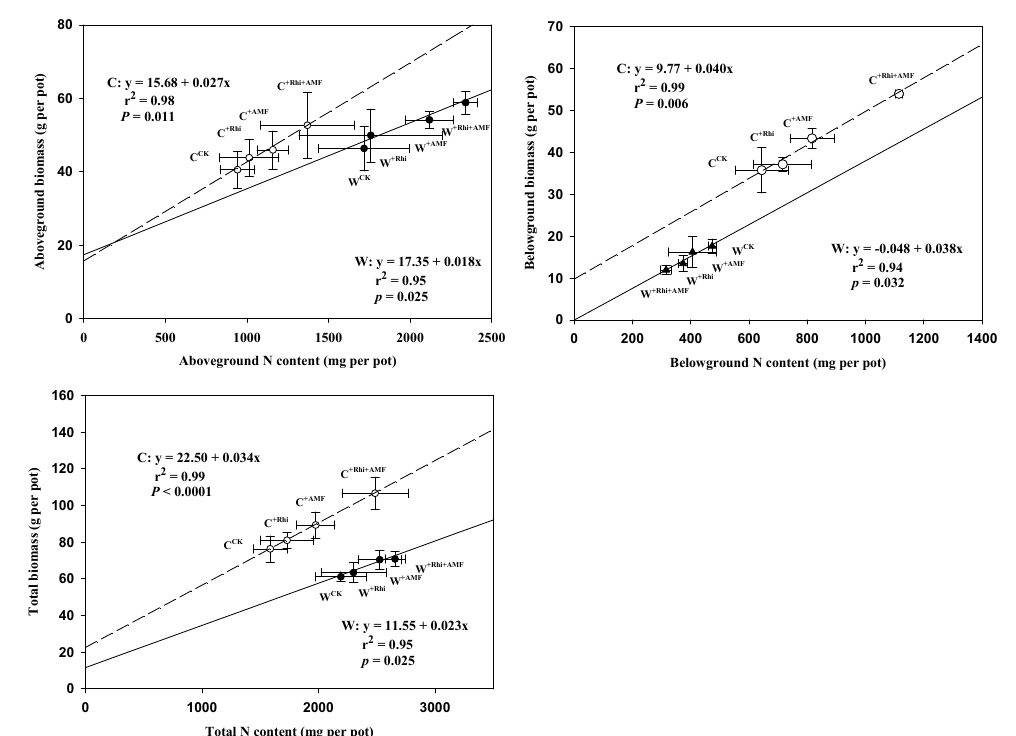
Figure 3. Relationship between biomass and N content of various parts of white clover and citrus. Data are mean ± SE ( n = 4) and white clover are indicated by solid symbols and citrus by open symbols. Regressions are shown for white clover (solid lines) and for citrus (dashed lines). Abbreviations: W, white clover; C, citrus; CK, no rhizobium and no arbuscular mycorrhizal inoculation; +Rhi, inoculated with rhizobium; +AMF, inoculated with mycorrhizal fungus.